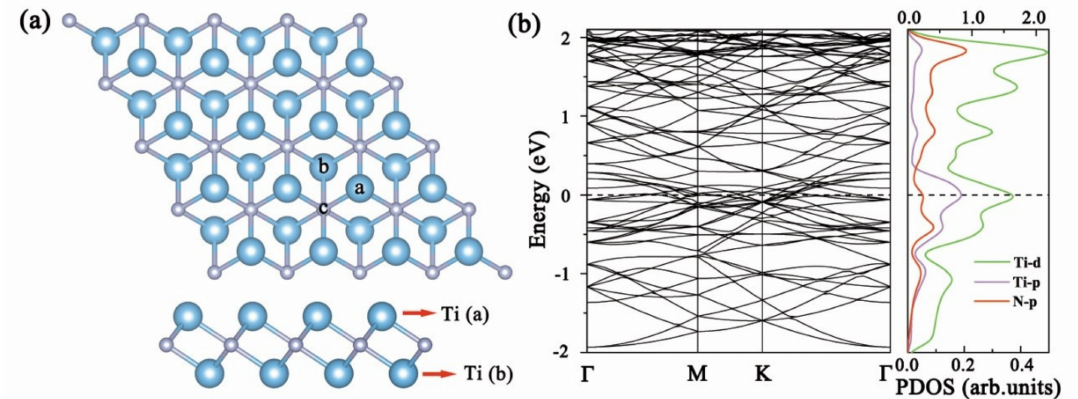
Figure 1. ( a ) Top and side view of the optimized structures for Ti 2 N monolayer (blue and silver balls represent Ti and N atoms, respectively). ( b ) Band structure and projected density of states of Ti 2 N monolayer (Ti d -orbital uses top abscissa and other orbitals use bottom coordinate).